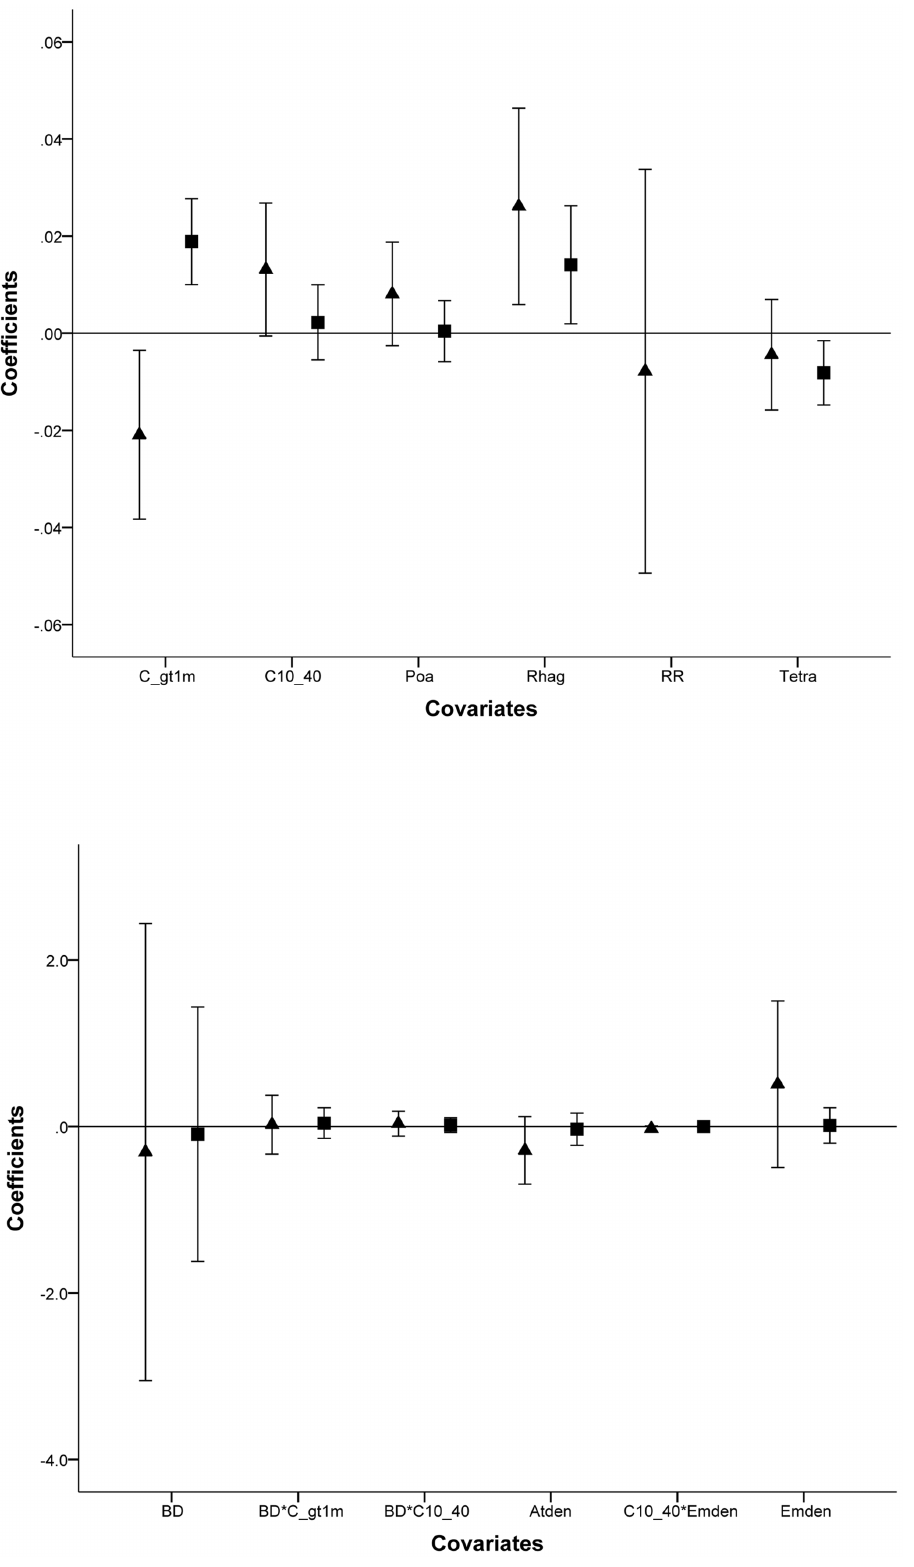
Figure 4. Error bar plot indicating the influence of model covariates on rodent activity levels. Model averaged coefficients (mean 6 95% CI) for black rats (square) and house mice (triangle) demonstrating their influence on activity levels for floristic and structural covariates (a) and covariates including burrow density (b).